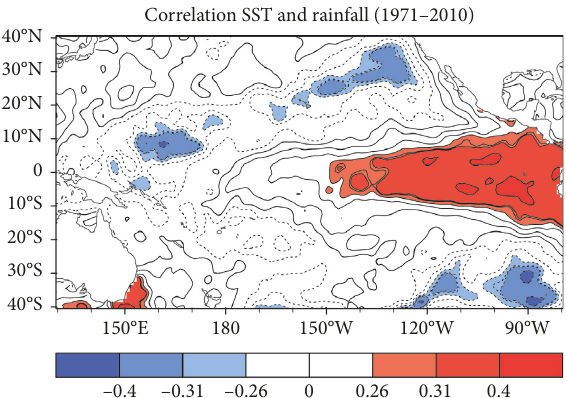
Figure 3: The correlation between interannual variation sequence of SEC autumn rainfall and SST and 0.26, 0.31, and 0.4 denoting the criteria of 90%, 95%, and 99% confidence level of the t -test,